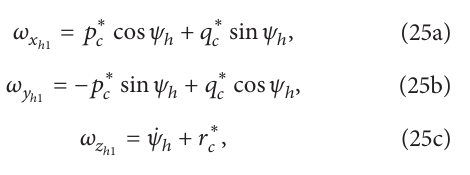
𝑂 𝑥 𝑦 𝑧 ℎ ℎ1 ℎ1 ℎ1 —the movable system connected with the external frame of the head, 𝑥 𝑦 𝑧 𝑂 ℎ ℎ ℎ ℎ —the movable system connected with internal the frame of the head (including